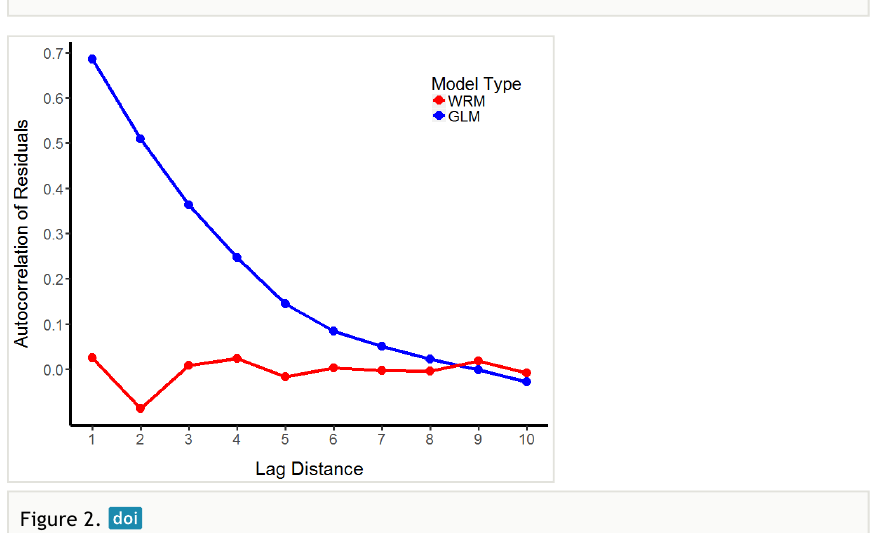
Figure 2. Autocorrelation of residuals from WRM in comparison to GLM. WRM with level 1 performed best for the musdata data set. Spatial autocorrelation is computed as Moran’s I using the ac ff t